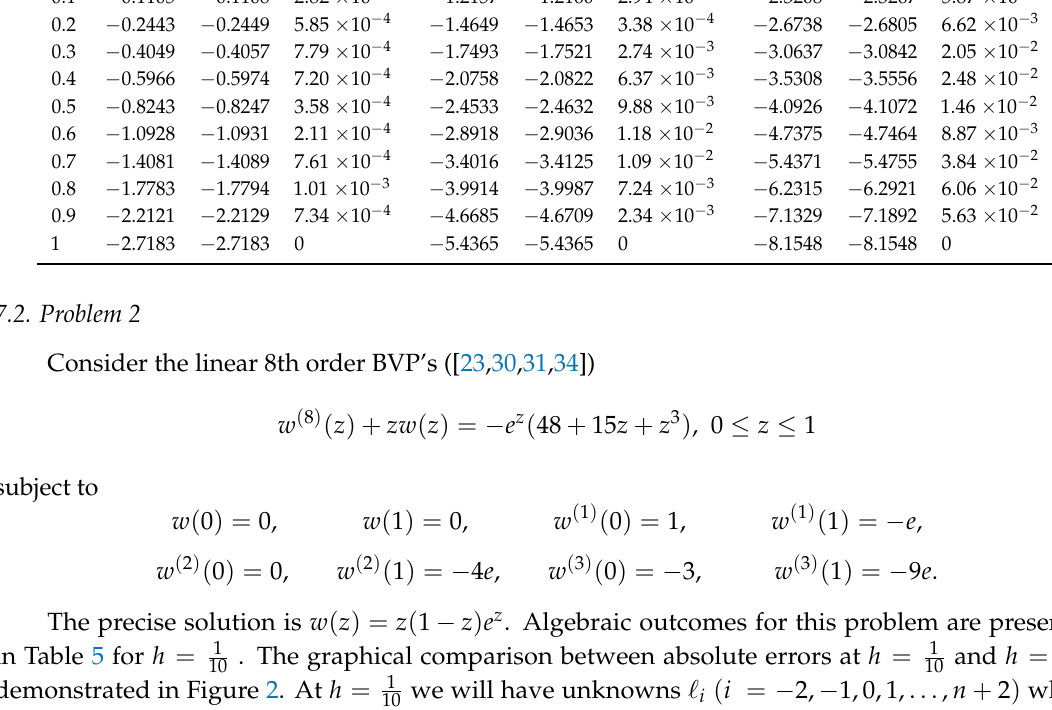
Table 5. Comparison of exact solution and Cubic B-spline solution of Problem 2 at h = 1